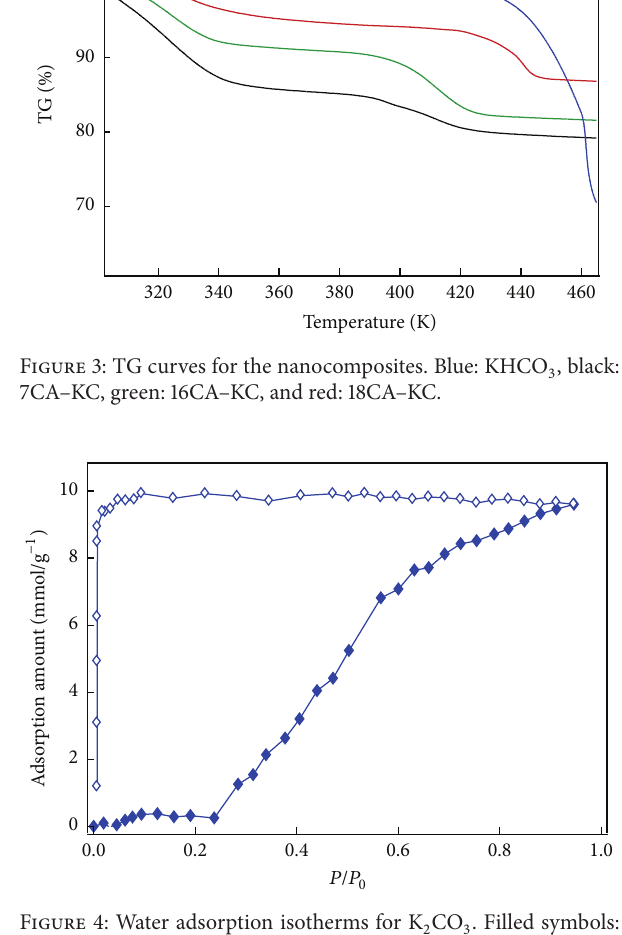
Figure 4: Water adsorption isotherms for K 2 CO 3 . Filled symbols: sorption; open symbols: